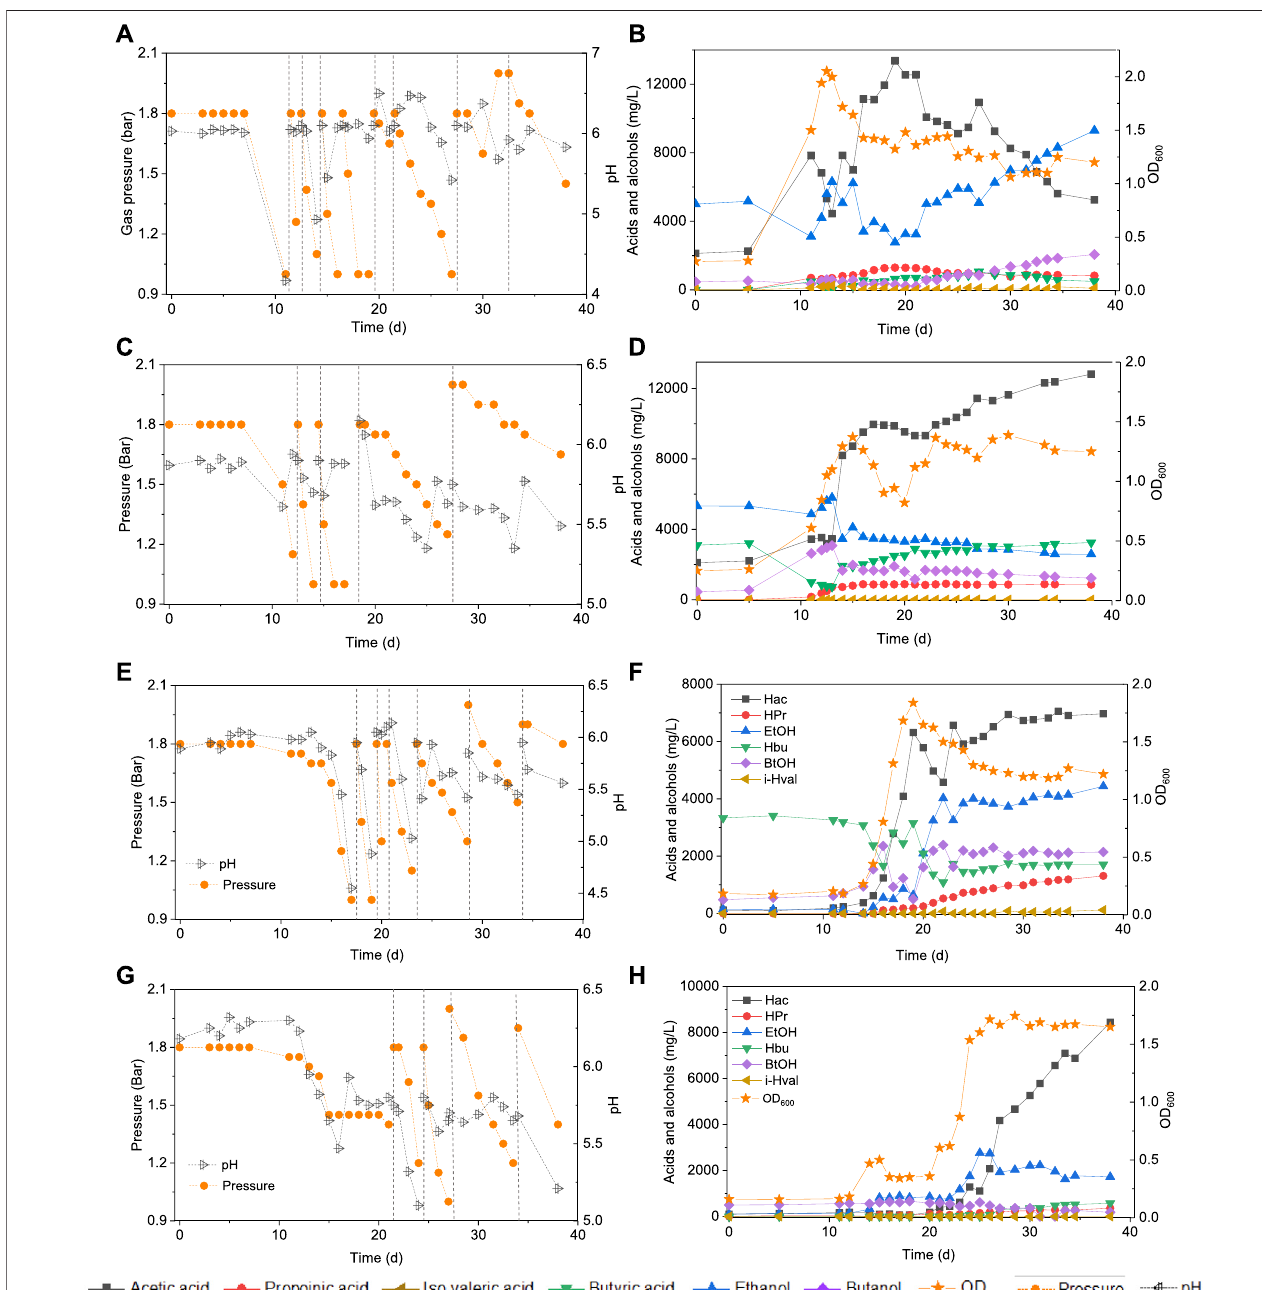
FIGURE 2 | Production of acids and alcohols, cells concentration and change of gas pressure in semi-gas feeding reactors by enriched sludge from 6 th transfer using CO as the carbon source. (A) and (B) exogenous acetic acid and ethanol; (C) and (D) exogenous acetic acid, ethanol and butyric acid; (E) and (F) exogenous butyric acid; (G) and (H) control without exogenous acids or ethanol. The dashed lines represent CO addition and pH regulation.